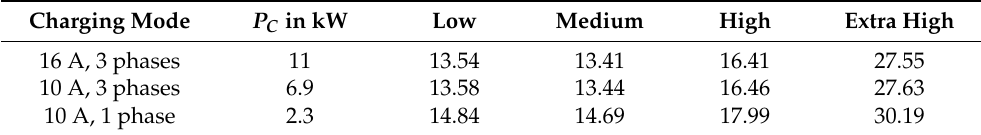
Table 9. WLTP energy consumption in kWh/100 km sectioned in dependence of different charging modes for the Kia e-Niro.